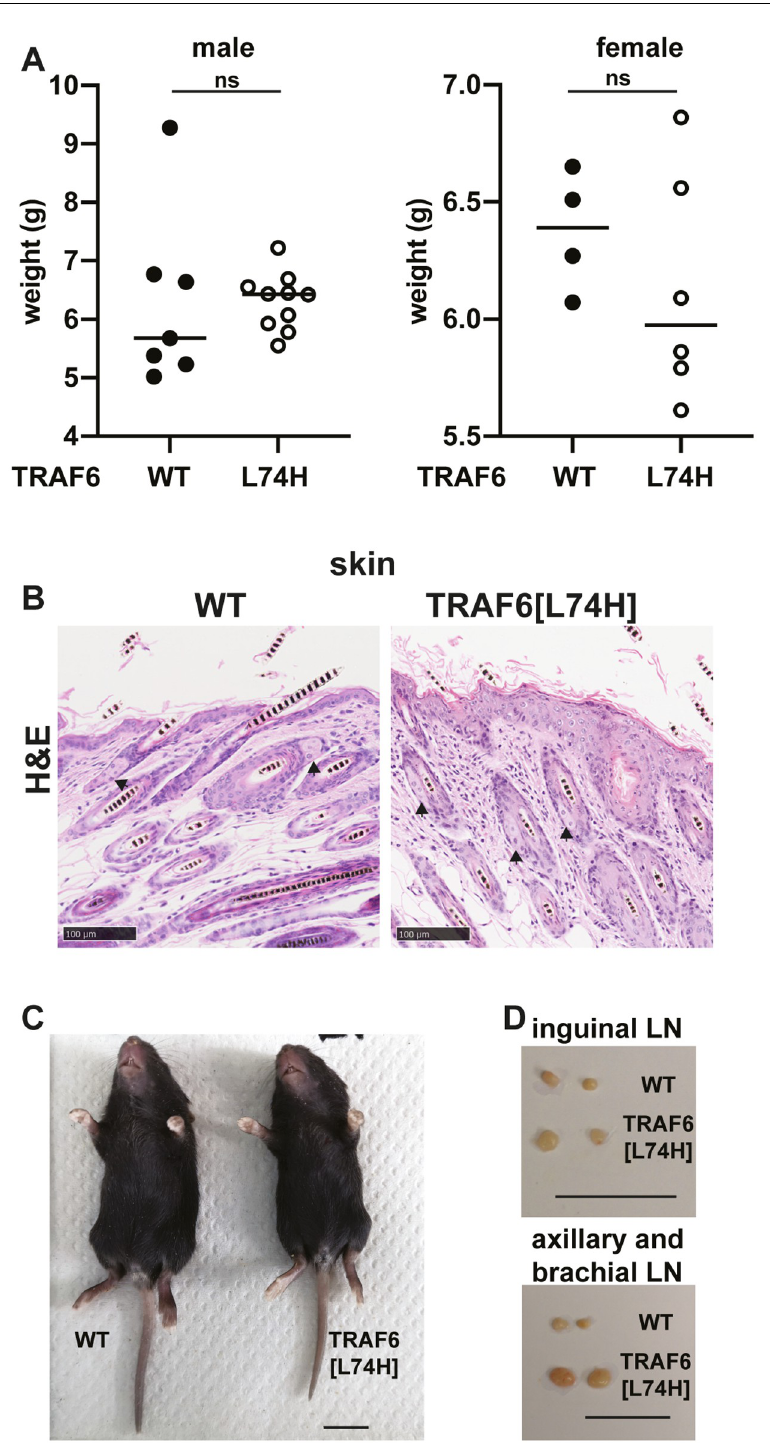
Fig 1. TRAF6[L74H] mice phenotype. (A) Body weight of 16 days old male WT (n = 6) and TRAF6[L74H] (n = 8) mice (left-hand panel) and female WT (n = 4) and TRAF6[L74H] mice (n = 6) (right-hand panel). (B) Representative hematoxylin-eosin (H&E) staining image of the skin from WT and TRAF6[L74H] mice. Arrows show sebaceous glands. (C) Representative image of a 16-day old WT and TRAF6[L74H] male mice. (D) As in C, except images show enlarged inguinal (upper panel) and axillary and brachial lymph nodes (lower panel). Symbols in A represent individual biological replicates. Statistical significance was calculated using the Mann-Whitney test (left-hand panel) and unpaired t test with Welch’s correction. Individual values, descriptive statistics and results from the statistical analysis are provided in S1 File.